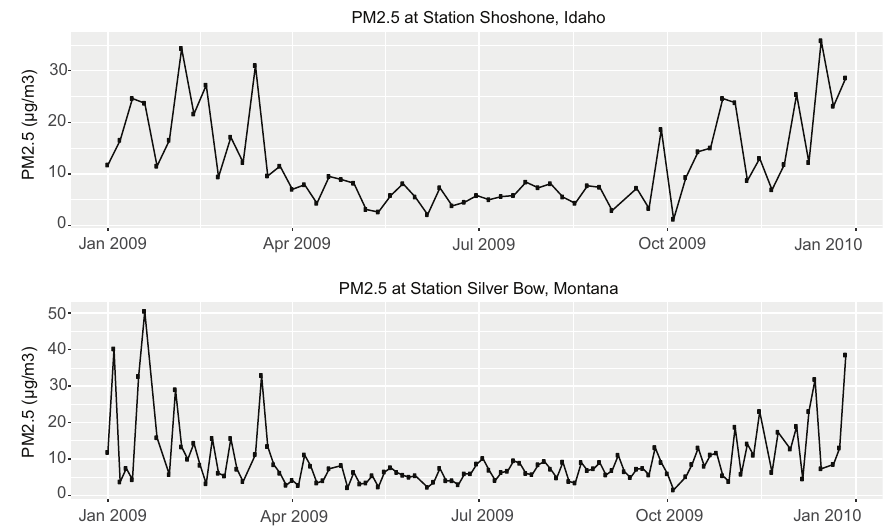
Figure 6. Verification of a spatial pattern in a region near the Idaho–Montana border in 2009. Plots of PM 2.5 measurements at two monitoring stations in Idaho and Montana using PM 2.5 daily data from AirNow in 2009.